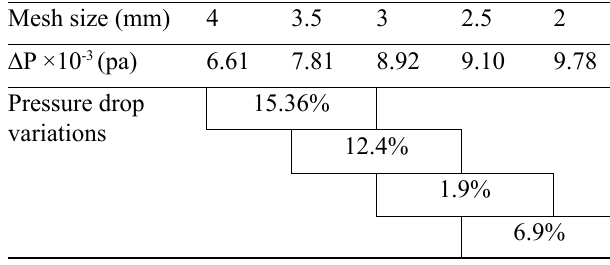
Table 7. Grid independence results for a packed bed with cone particles in N=7.86.